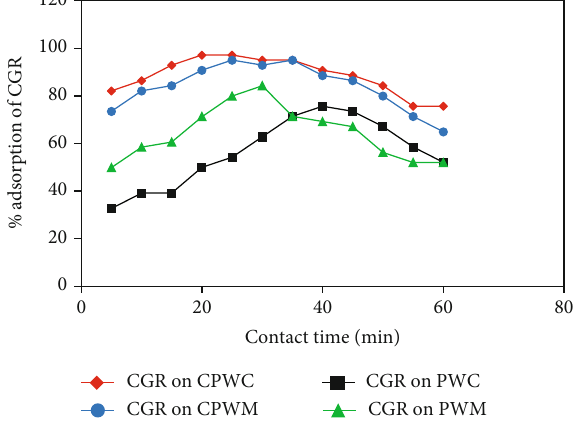
Figure 9: Optimization of contact time.